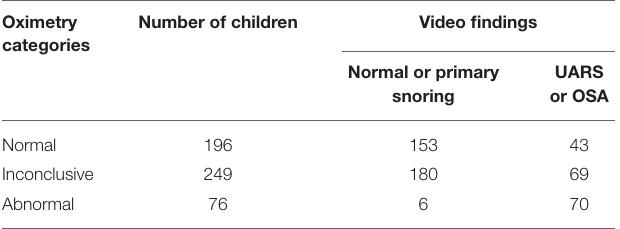
TABLE 2 | Sleep study categories compared with oximetry findings.